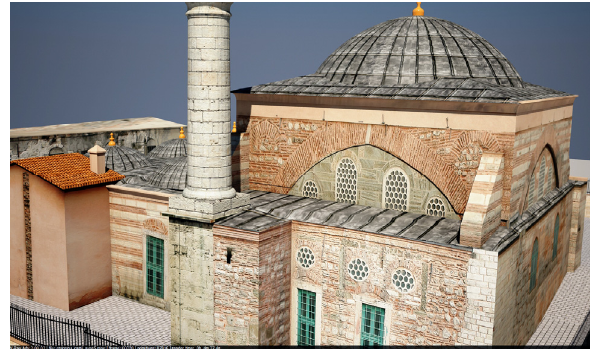
Figure 6 . The LOD 2 Representation of a Mosque Generated based on Terrestrial Laser Scanning